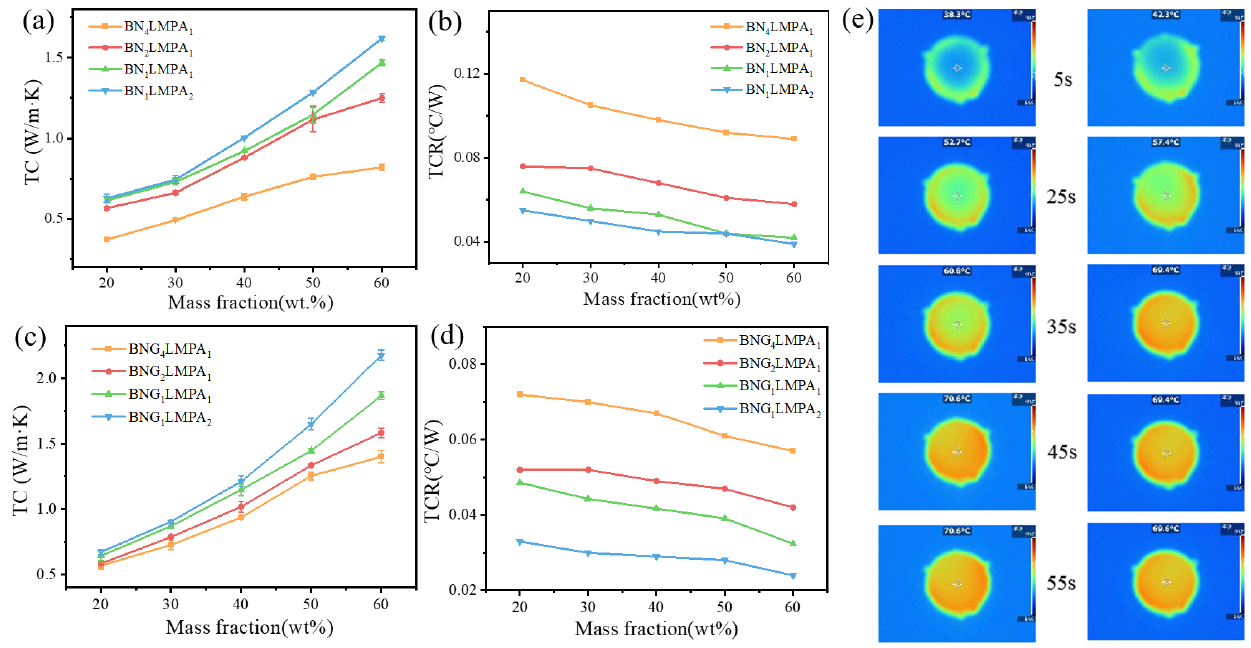
Figure 4. TC and TCR of ( a , b ) BN-LMPA and ( c , d ) BNG-LMPA; ( e ) Infrared thermography of BN 1 LMPA 2 /SG ( left ) and BNG 1 LMPA 2 /SG ( right ).